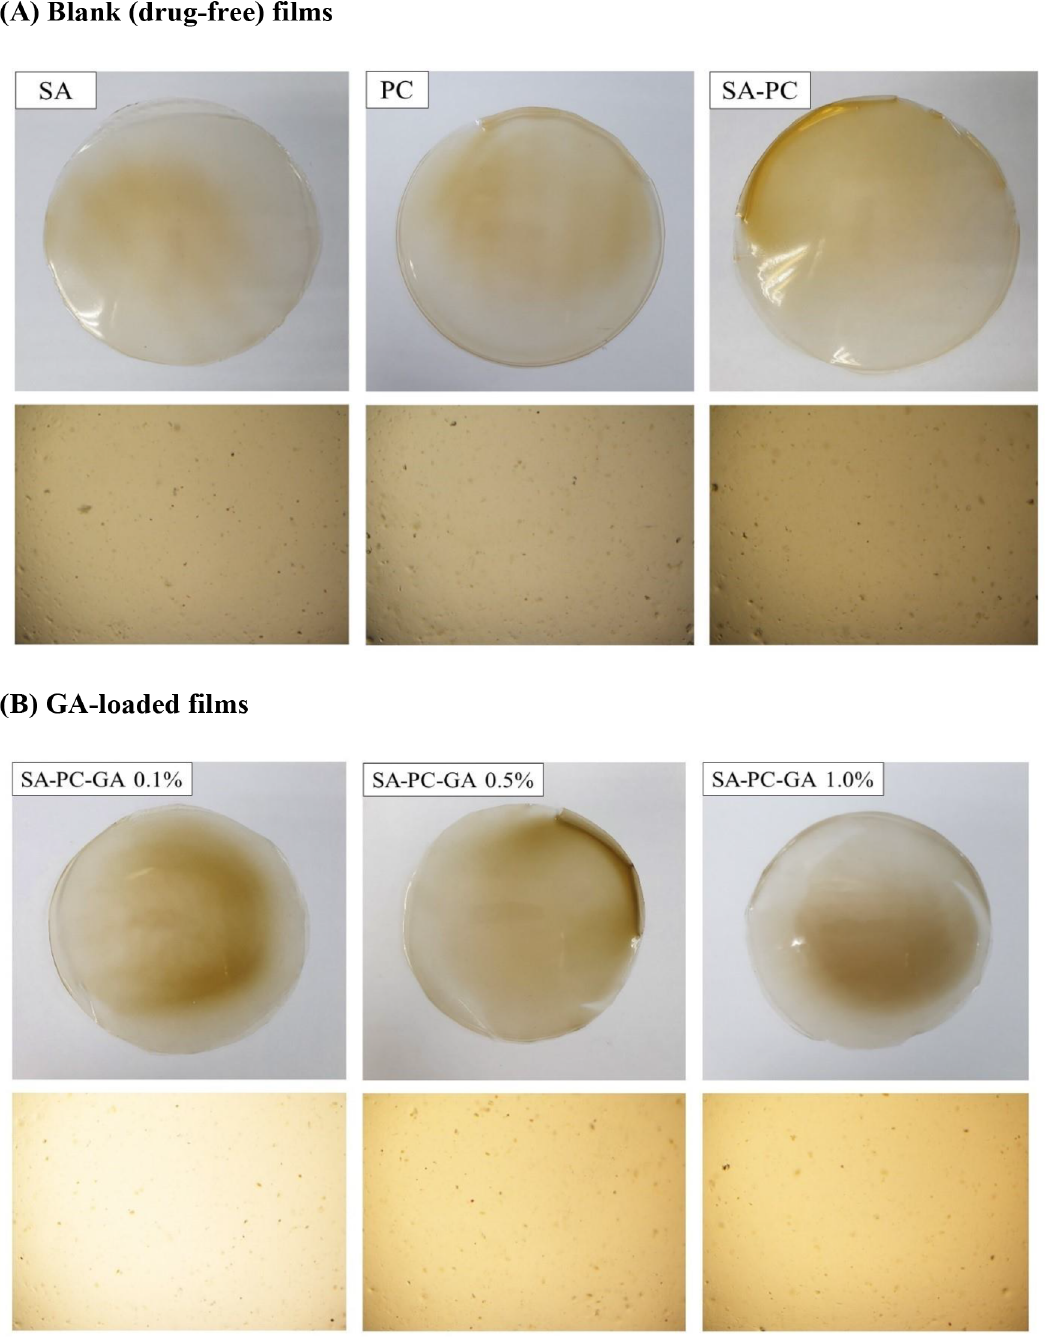
Figure 1. Macroscopic and microscopic images of (A) SA, PC and blank SA-PC hydrocolloid films and (B) Gallic acid-loadedfilmsofvariousstrengths(SA-PC-GA0.1 % ,0.5 % and1.0 % w/v)takenonphysicalexaminationand under brightfield microscope at 4 (cid:5)